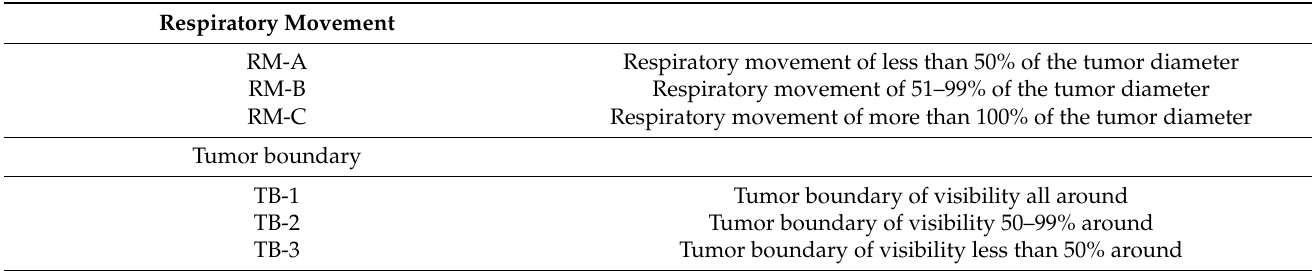
Figure 1. Manual labeling. Image of CE-EUS. The left side of the image is B-mode, and the right side is the extended pure harmonic detection (ExPHD) mode. The tumor was labeled with blue color as the ground truth on each image. CE-EUS: Contrast-enhanced endoscopic ultrasound. Table 1. Classification of degree on respiratory movement and tumor